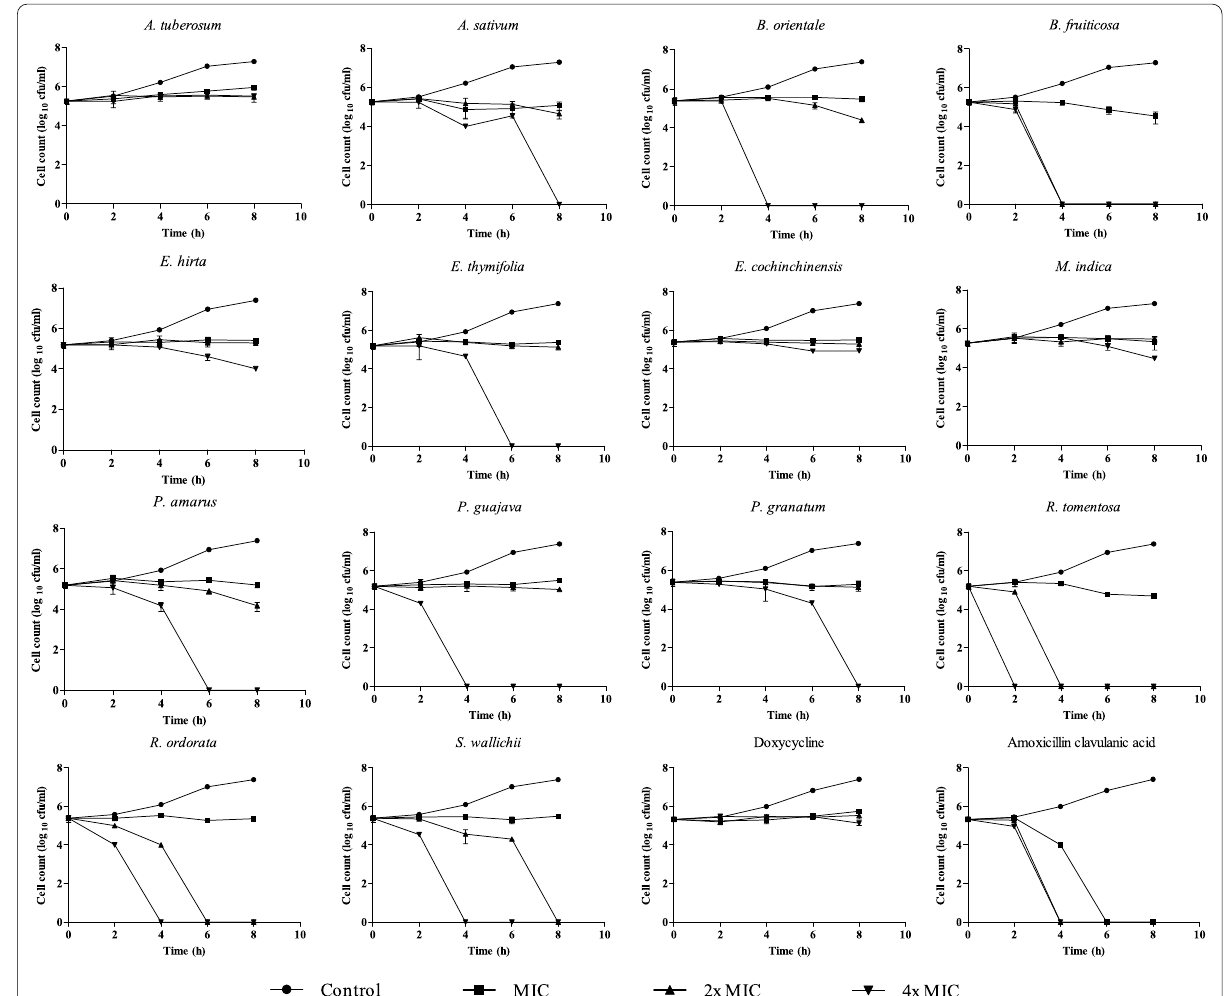
Fig. 1 Time-kill kinetics of herb juices and aqueous plant extracts against B. pseudomallei VTCC 70157 when treated at different dilutions of 1 2 MIC and 4 MIC. Data are presented in the mean values × ×